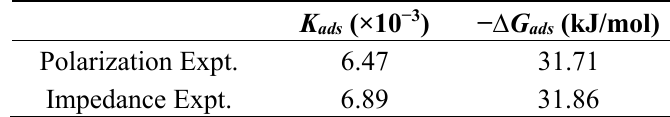
Table 4. Adsorption constant and change in free energy of adsorption of SB on mild steel surface from polarization and impedance experiments at 303